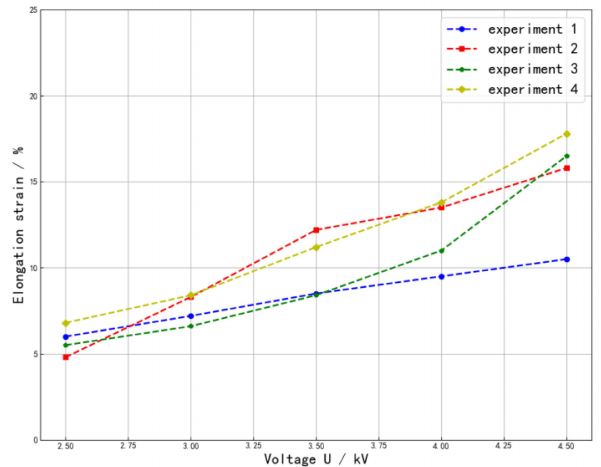
Figure 11. Single-degree-of-freedom experimental drive unit elongation strain–voltage